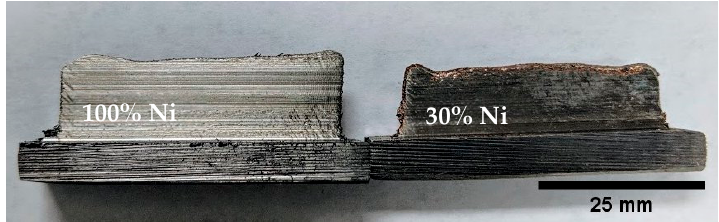
Figure 4. Machined thin-wall deposits of solely nickel-rich 100/0 (left) and copper-rich 30/70 (right) alloys, with a significant difference in overall height for the same 40 layers of deposition.